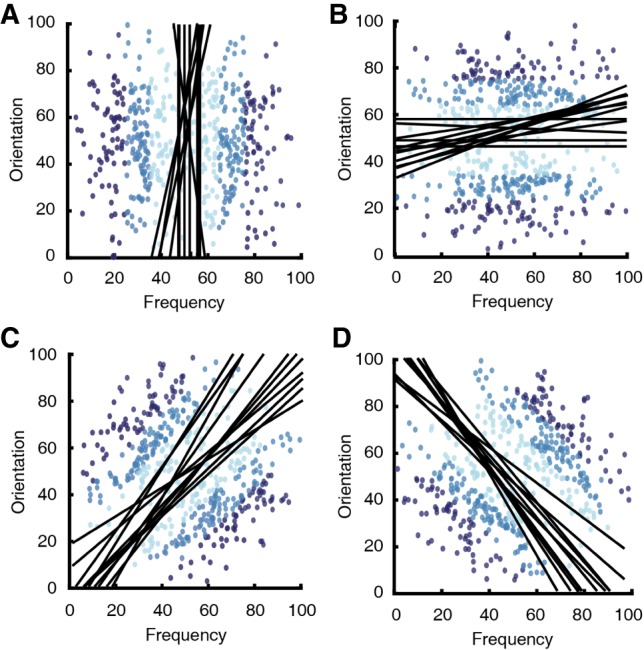
Estimated decision boundaries obtained from GRT. Three models were fit to each rat's generalization data: two models that assume a unidimensional decision boundary (synonymous to an RB strategy) and one that assumes a bidimensional decision boundary (synonymous to an II strategy). The best fit was determined according to the model with the lowest AIC value. (A,B) The best fitting decision boundaries for rats learning an RB task. (C,D) The best fitting decision boundaries for rats learning an II task.